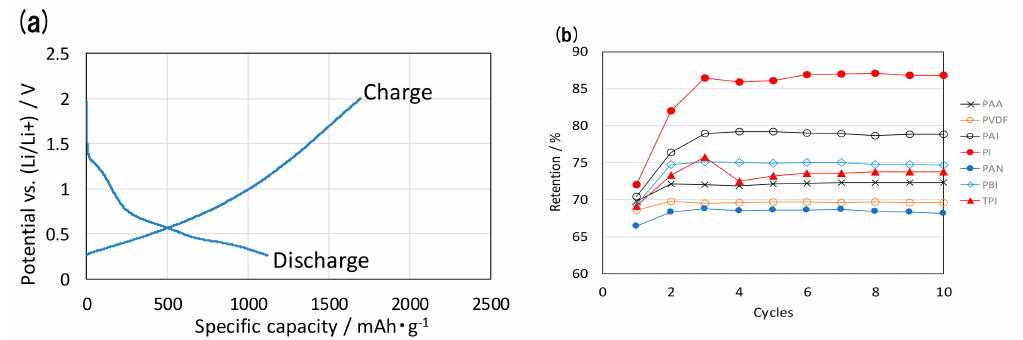
Figure 7. Electrochemical property of binder with Cu powder as conductive additive for cyclic characteristics. ( a ) Charge–discharge characteristics of polyimide (PI). Specific capacity indicates a capacity per weight of only PI included in an anode electrode of a 2032 type coin cell. ( b ) Retention